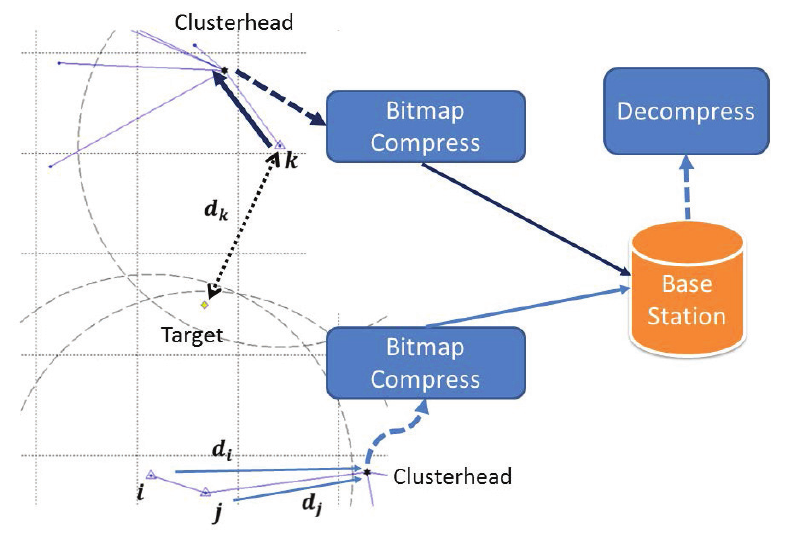
Figure 1. The result area of the Data Compressing-based Target Tracking Protocol